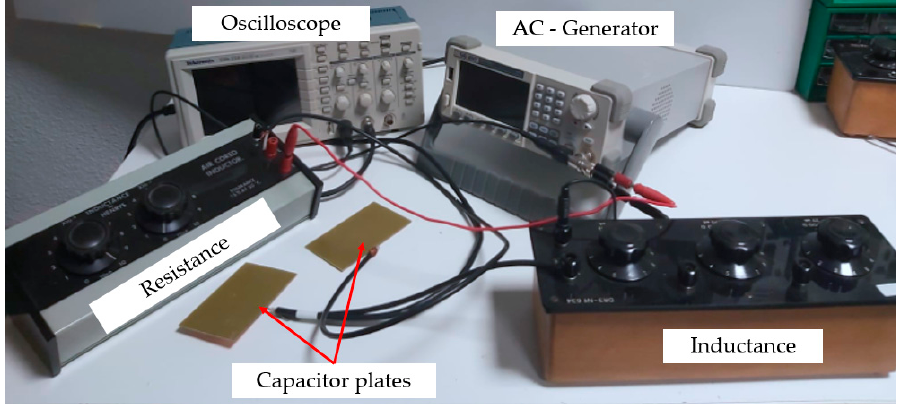
Figure 13. Capacitive measurement equipment used.